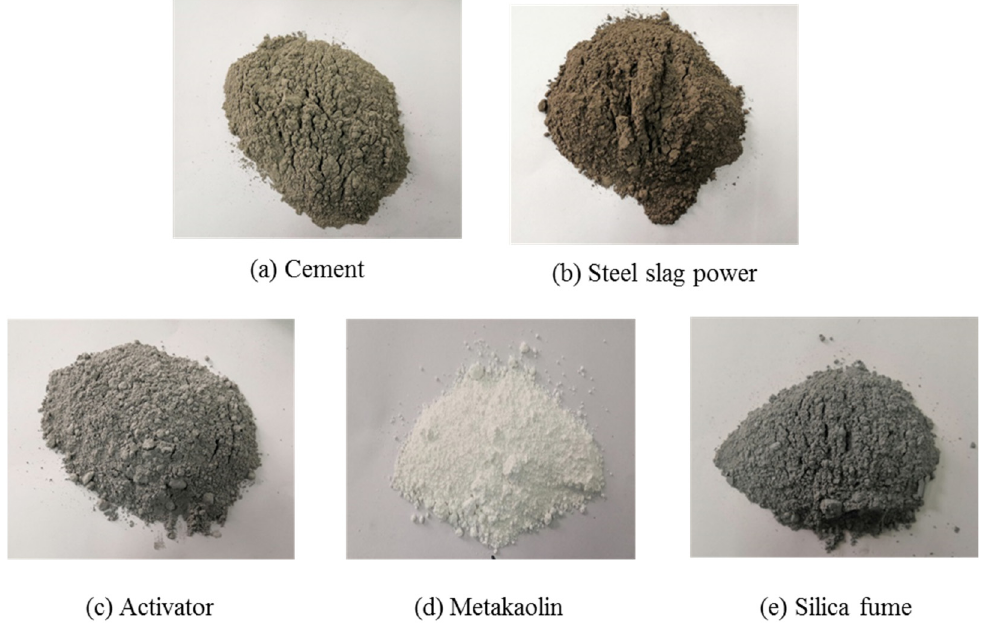
Figure 2. Samples of cementitious material components in this study ( a ) cement; ( b ) steel slag powder; ( c ) activator; ( d ) metakaolin and ( e ) silica fume.